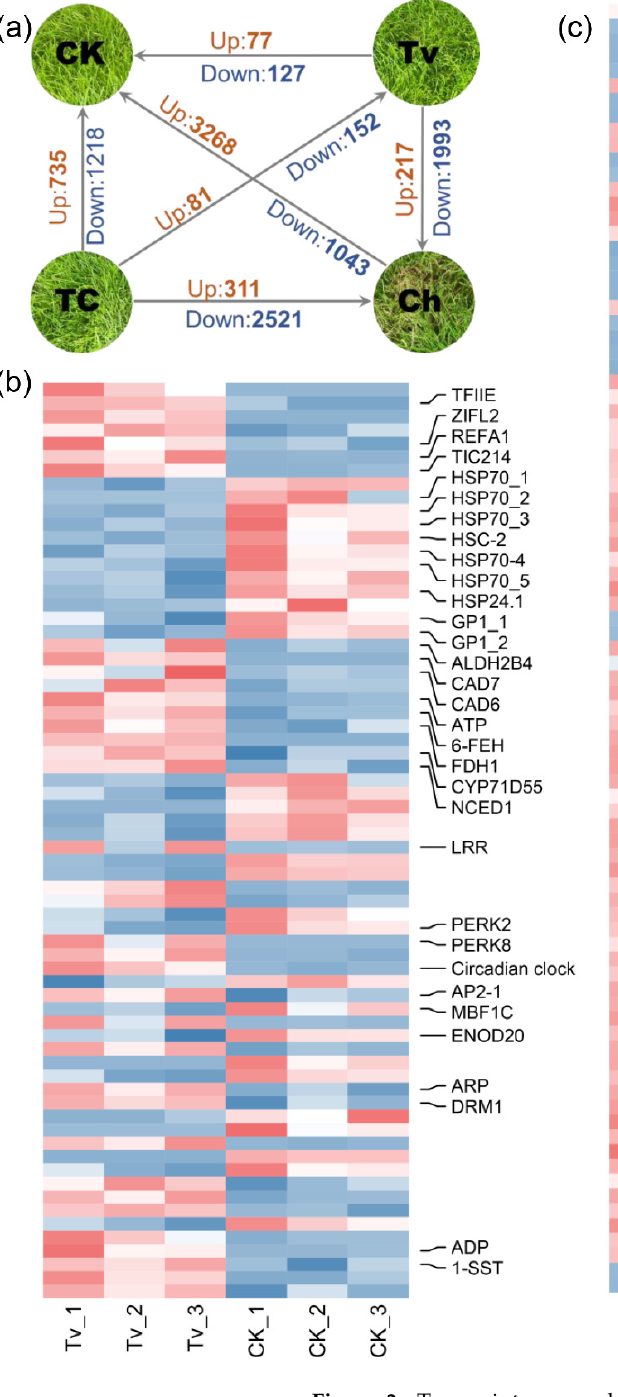
Figure 3. Transcriptome analysis of As leaves after colonization of T. virens and infection by C. homoeocarpa at 19 dpi. ( a ) Schematic overview of the DEG comparison with condition of |log2FC| ≥ 1 & Padj < 0.05 between different treatments. ( b ) Expression of DEGs (filtered with |log2FC| ≥ 2 & Padj < 0.01) between T. virens colonization (Tv) and control (CK). ( c ) Expression of DEGs upregu ‐